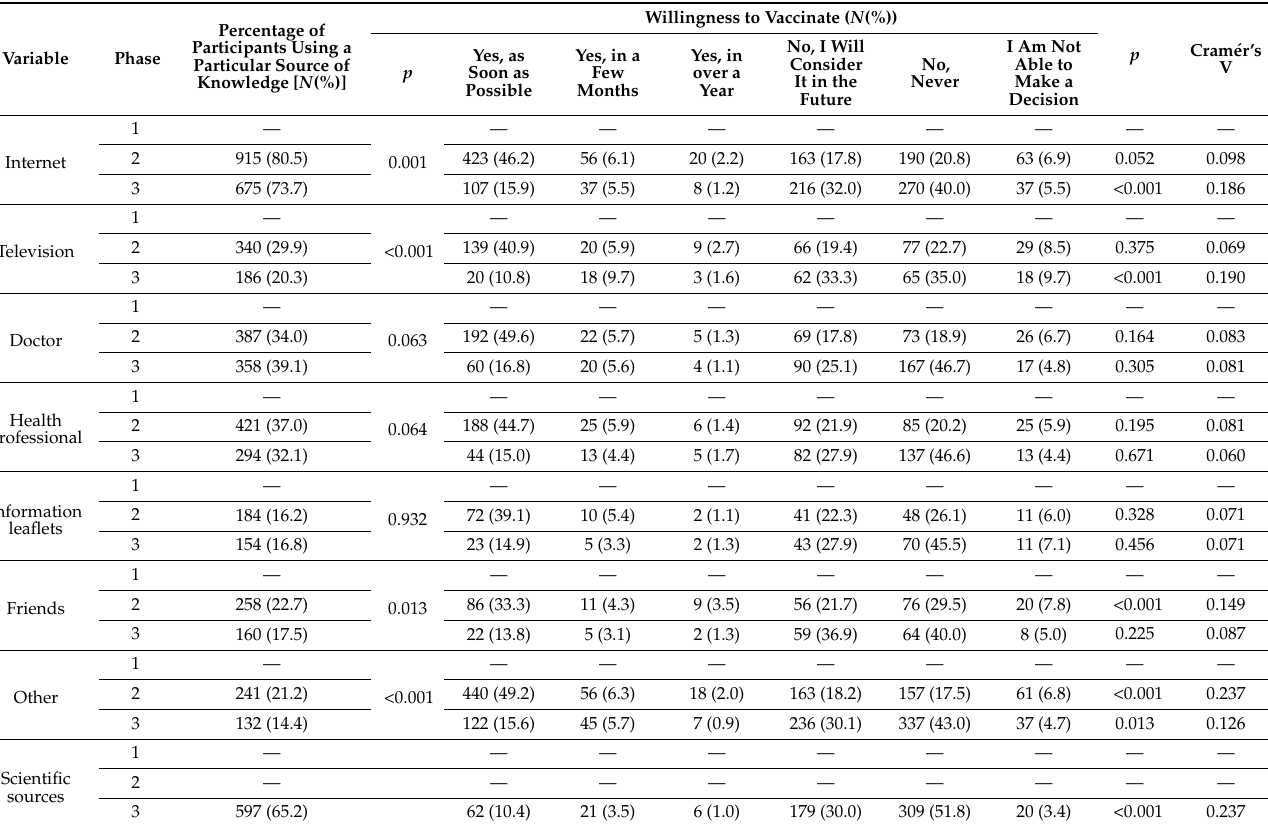
Table 4. Sources of knowledge about vaccines and the willingness to vaccinate against